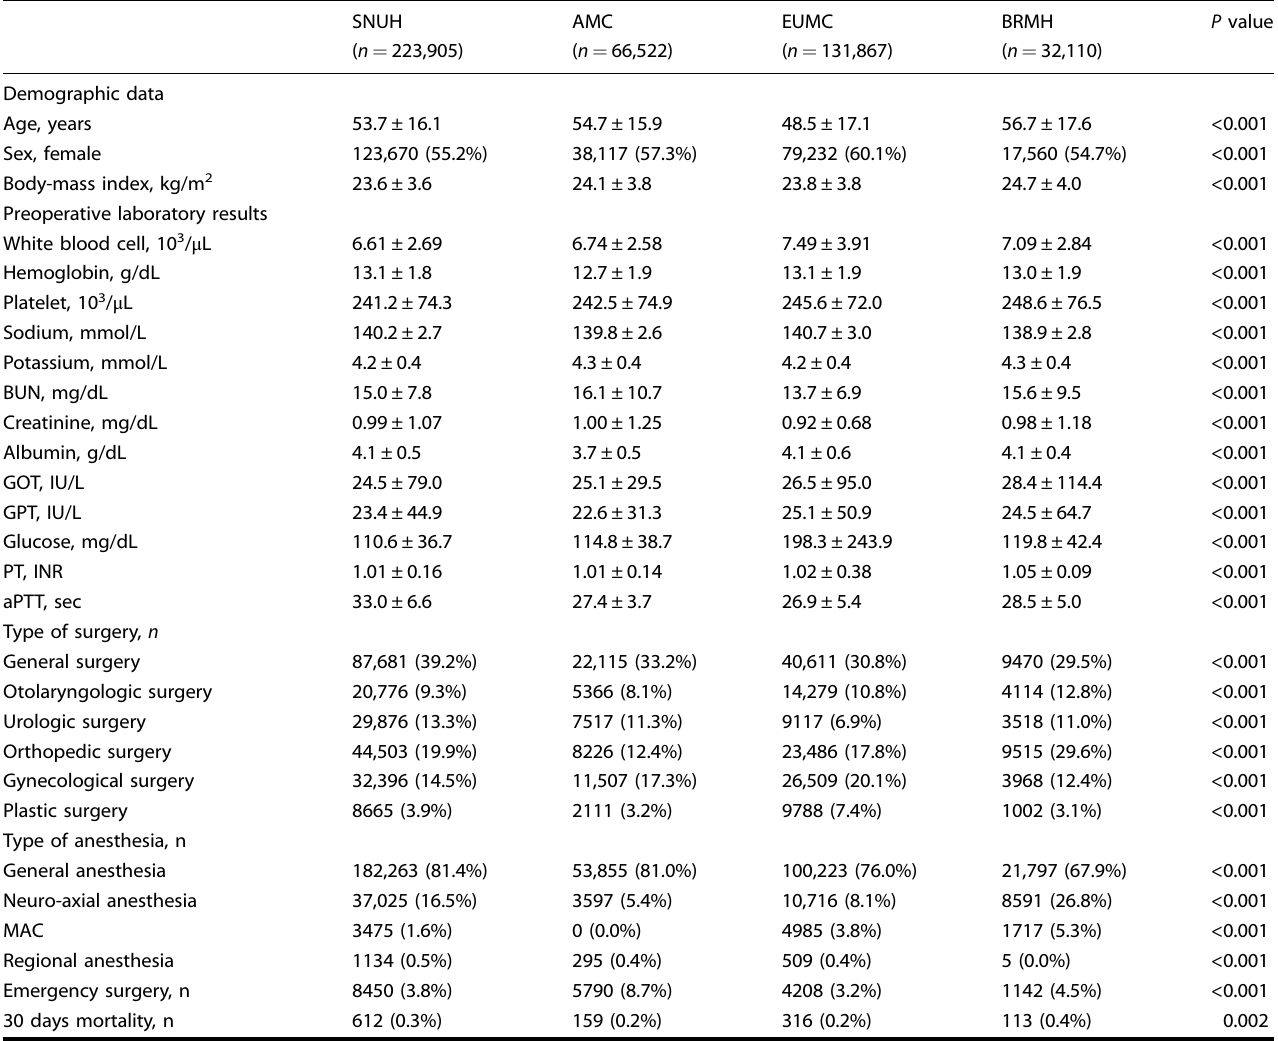
Table 1. Data characteristics of the four medical